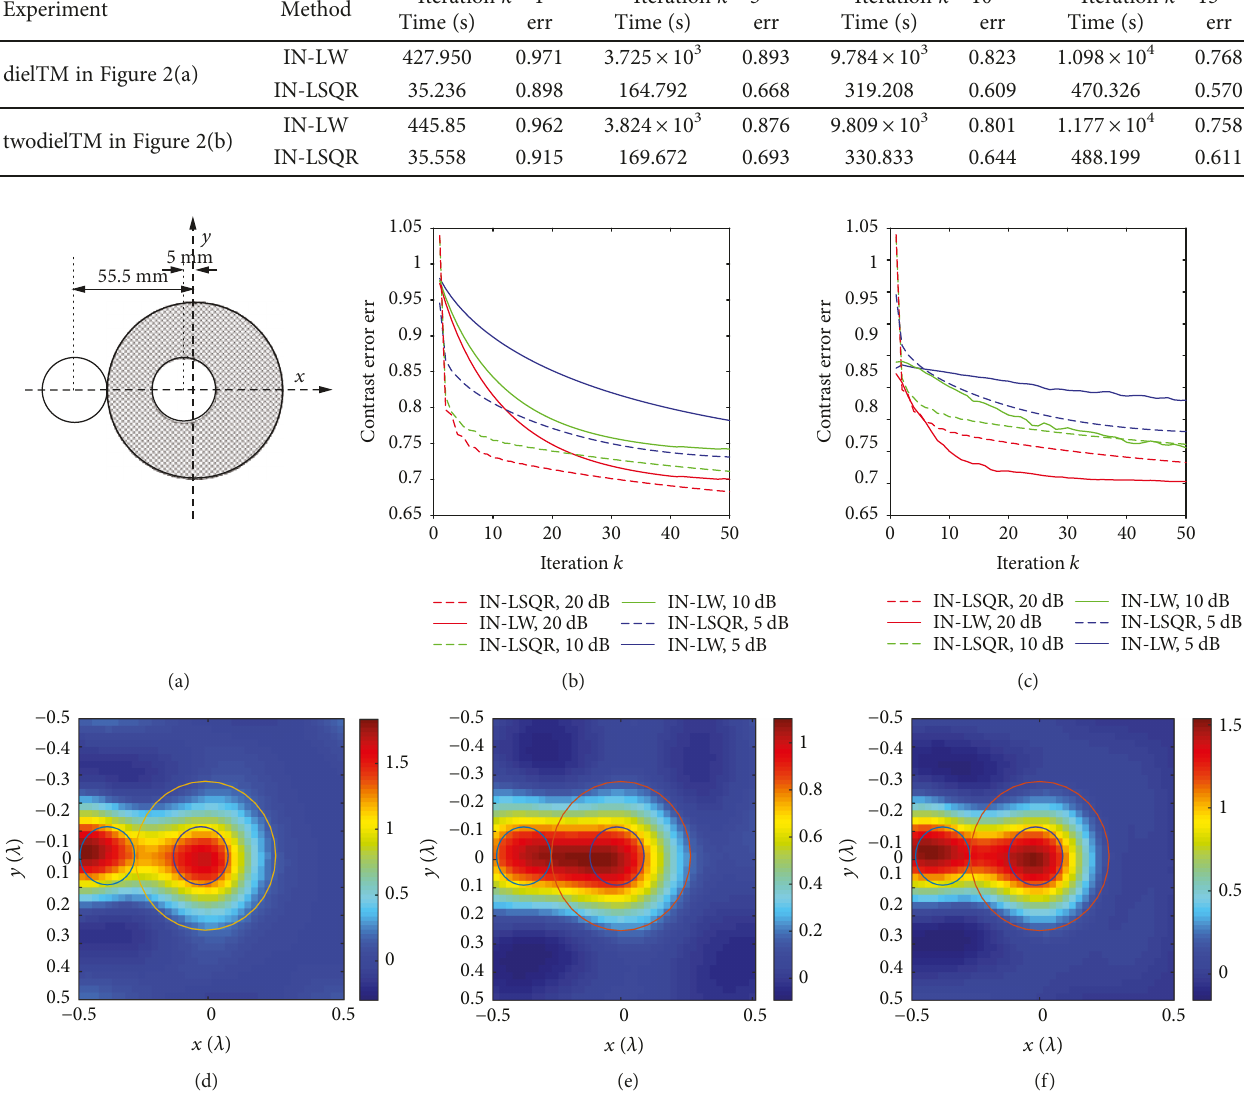
Figure 5: FoamTwinDiel: (a) actual pro fi le of FoamTwinDiel; (b) err computed by IN-LSQR and CSI for di ff erent noise levels; (d) contrast pro fi le recovered by IN-LSQR for 20 dB noise; (e) contrast pro fi le recovered by IN-LW for 20dB noise; (f) contrast pro fi le recovered by CSI for 20dB